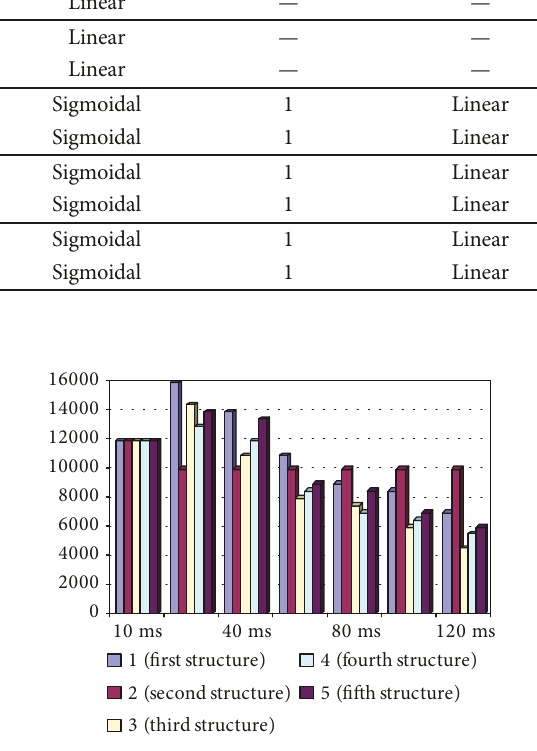
Figure 15: Power curves obtained with fi ve neuronal